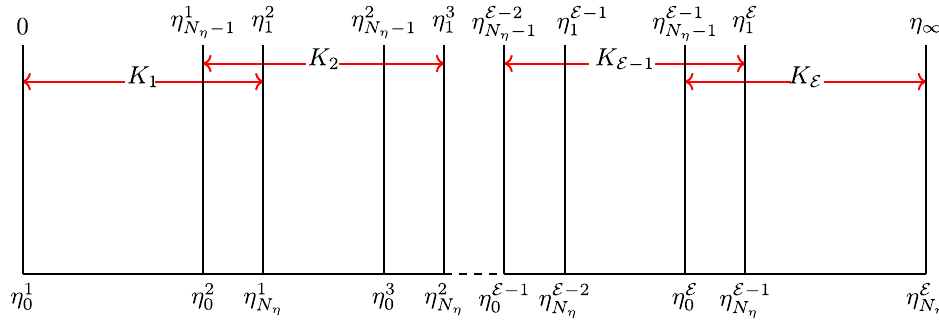
Figure 2: Overlapping domain decomposition of [ ] η 0,